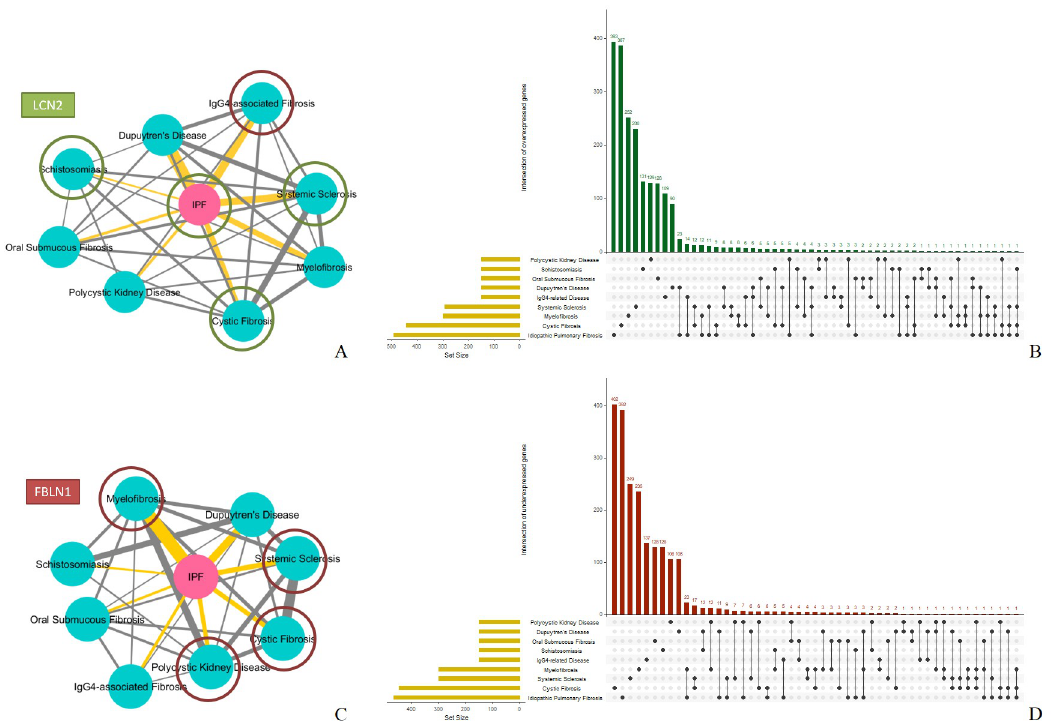
Fig 2. Common-gene participation networks. A. In this network, the edge values are relative to the number of common over- expressed genes between pairs of fibrotic diseases. IPF has 35 common over-expressed genes with Dupuytren’s Disease followed by 23 common with IgG4-related Disease and 20 with SSc . Our analyses indicate that the LCN2 gene is over-expressed in IPF , CF , Schistosomiasis and SSc . B. Upset plot depicting the number of common over-expressed genes among combinations of all 9 fibrotic diseases. C . In this network, the edge values are relative to the number of common under-expressed genes between pairs of fibrotic diseases. IPF has 28 common under-expressed genes with Myelofibrosis followed by 16 with Dupuytren’s Disease and 10 with SSc . Our analyses indicate that the FBLN1 gene is under-expressed in CF , Myelofibrosis , Polycystic Kidney Disease and SSc but over- expressed in IgG4-related Disease . Schistosomiasis has only 3 common over- and 3 common under-expressed genes with IPF . D. Upset plot depicting the number of common under-expressed genes among combinations of all 9 fibrotic